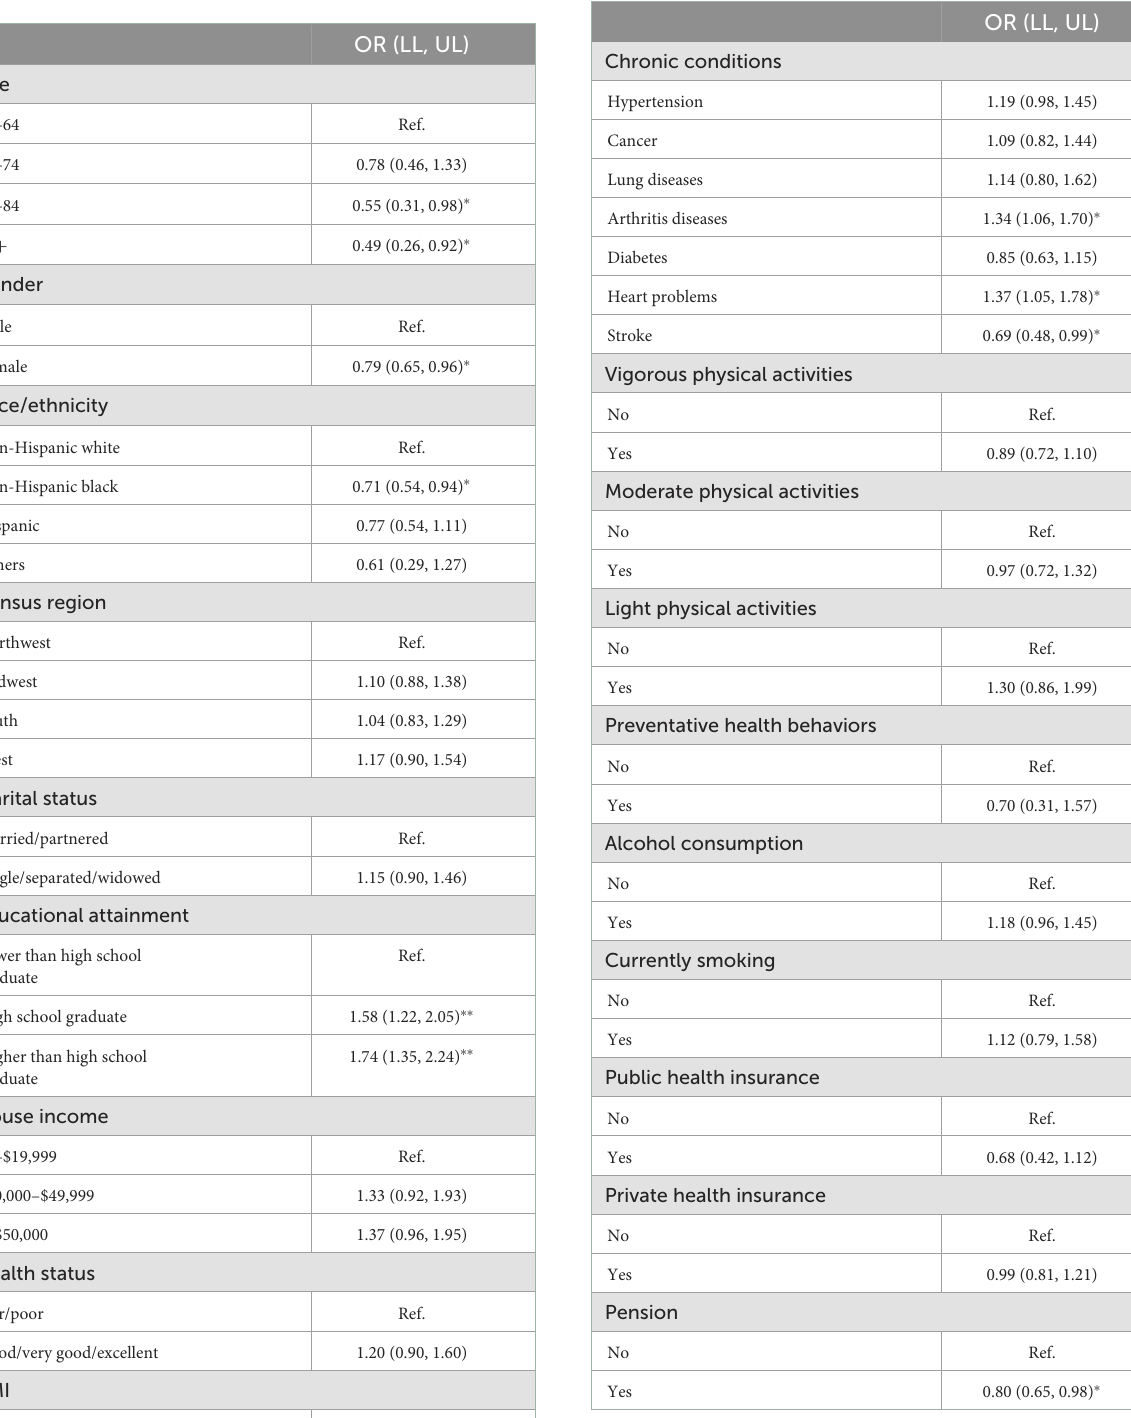
TABLE 2 Associated factors of early detection compared to late detection of